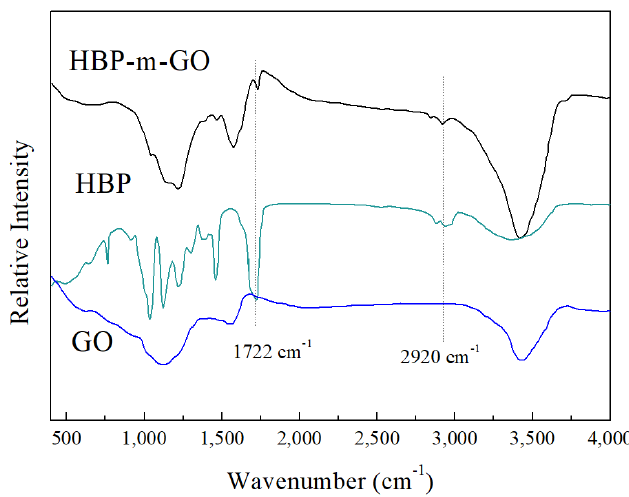
Figure 3. FT-IR spectrum of HBP, GO, and HBP-m-GO.